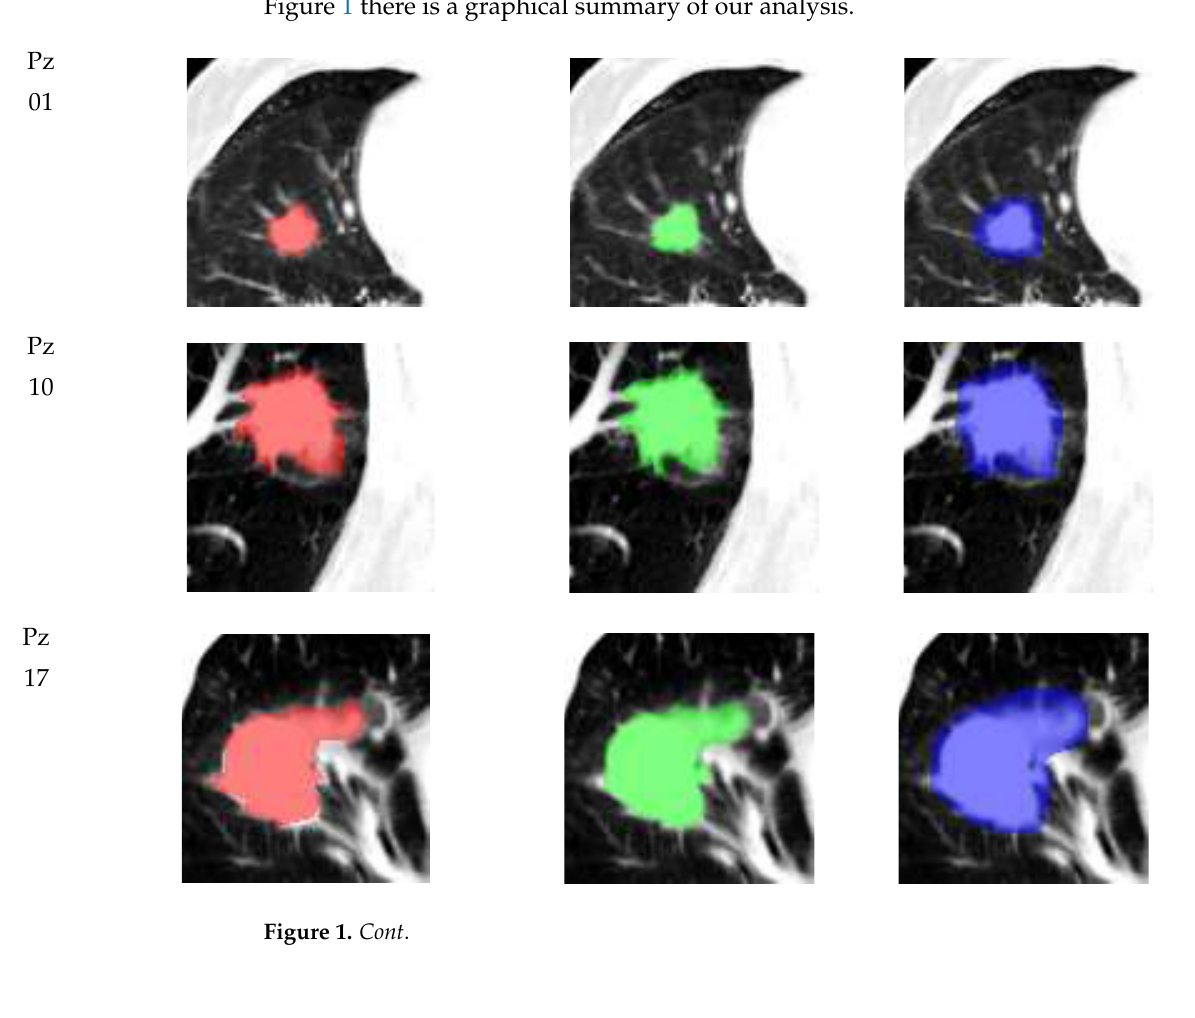
( c ) Figure 1. Illustrative examples of manual segmentations. For each patient on a row, different segmentations are showed superimposed on CT data: ( a ) polygonal, ( b ) free-hand accurate and ( c ) free-hand rough. 3. Results Patient demographic data and lesion type information are presented in Table 2. Figure 1 reports some illustrative examples of ROIs delineated on five randomly chosen patients. Flowchart of the method used in this study to evaluate robustness of radiomic features is showned in Scheme 1. Table 2. Patient characteristics. Sex